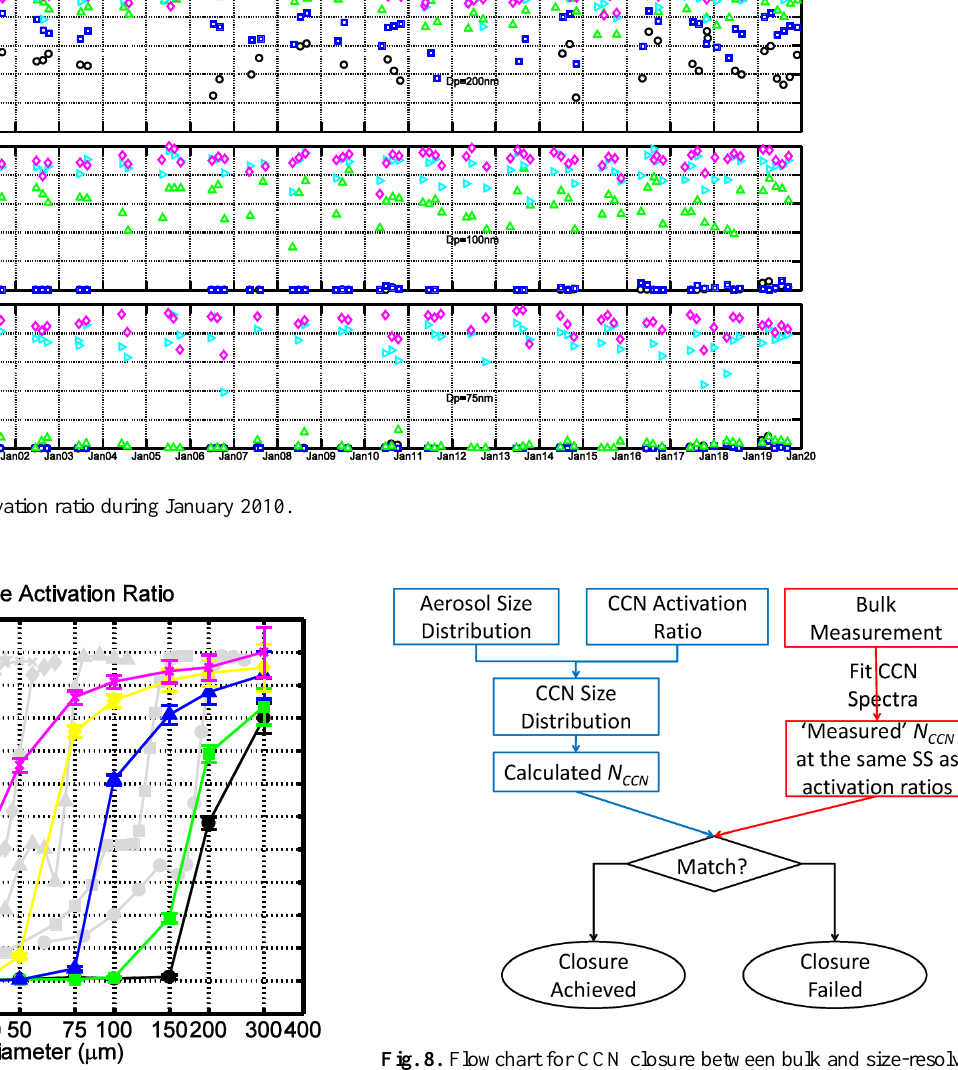
Fig. 7. Average activation curves for different supersaturations calibration curves of ammonia sulfate particles are shown as gray curves labeled with the effective supersaturation. The colored curves are the average activation curves of ambient aerosols.